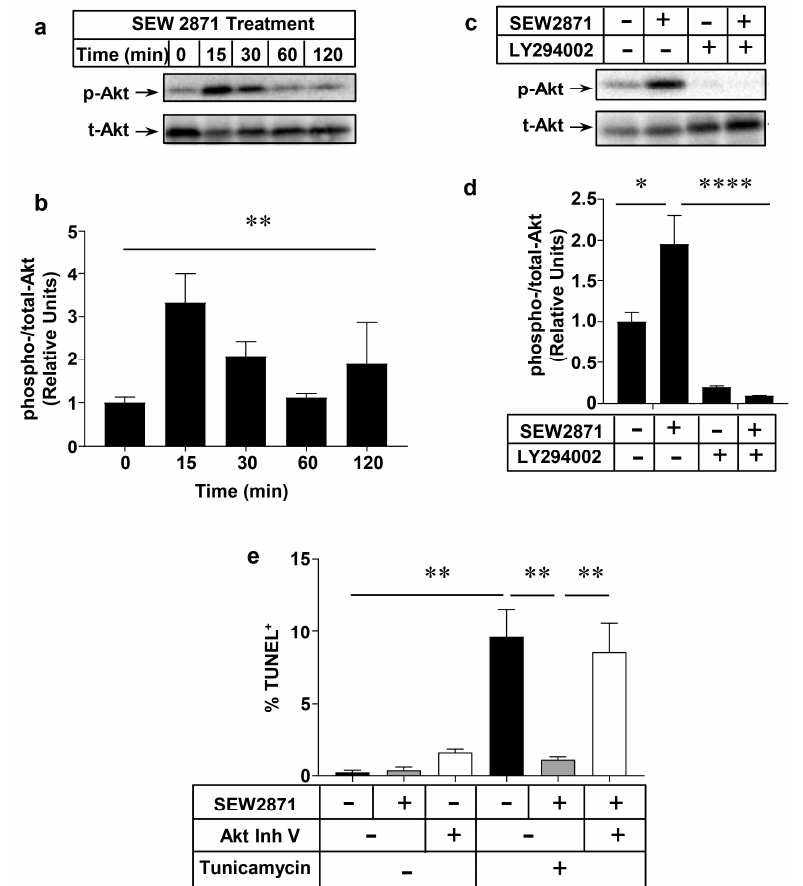
Figure 6. PI3K/Akt activation is required for SEW2871-mediated protection of macrophages